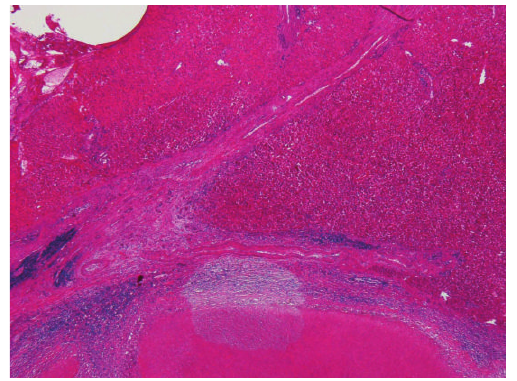
Figure 5: The finding of chronic hepatitis was observed in the background